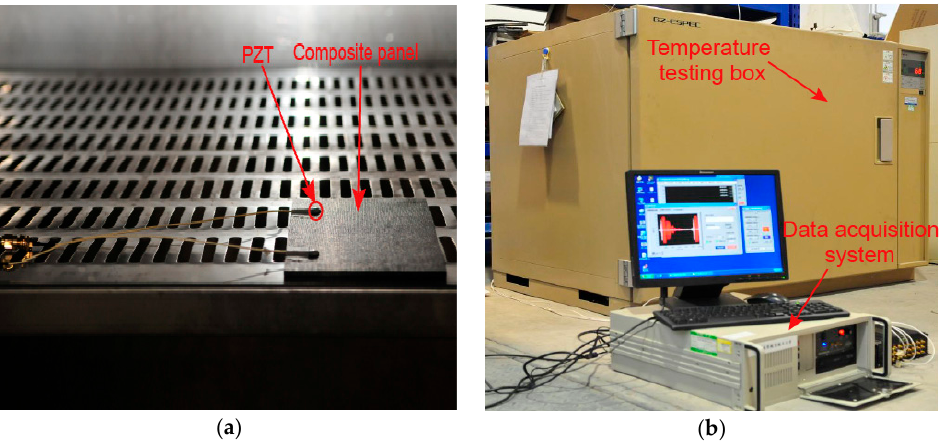
Figure 3. The experimental setup. ( a ) Specimen of composite panel; ( b ) Experiment test system.